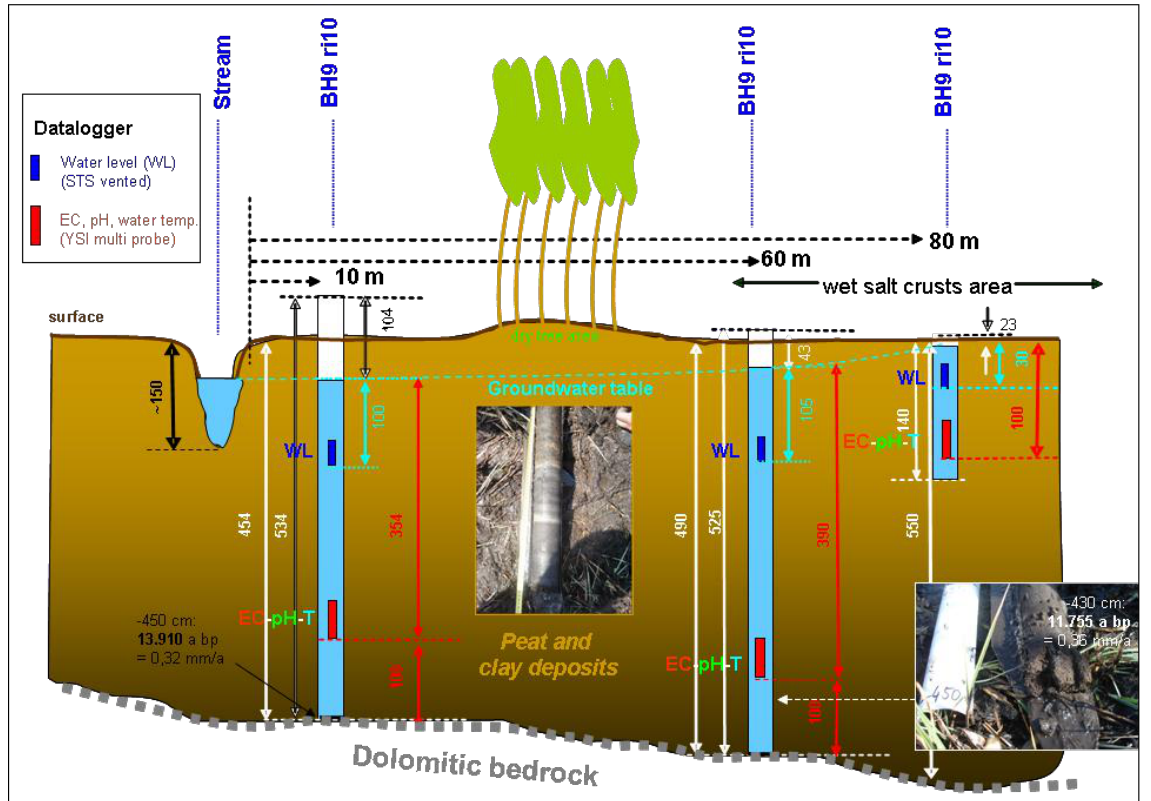
Figure 19. Cross section of the peat borehole transect at portion 9 indicating the position of different data logging sensors within the different